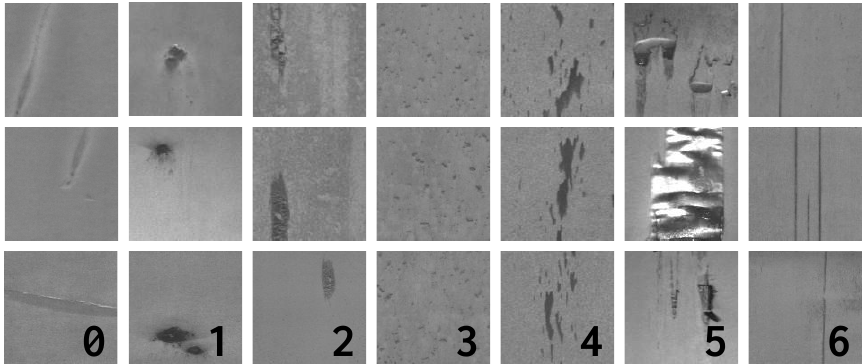
Figure 6. Seven kinds of strip steel surface defect image samples in X-SDD data set, including (0) finishing roll printing; (1) iron sheet ash; (2) oxide scale of plate system; (3) oxide scale of temperature system; (4) red iron; (5) slag inclusion; (6) surface scratch.